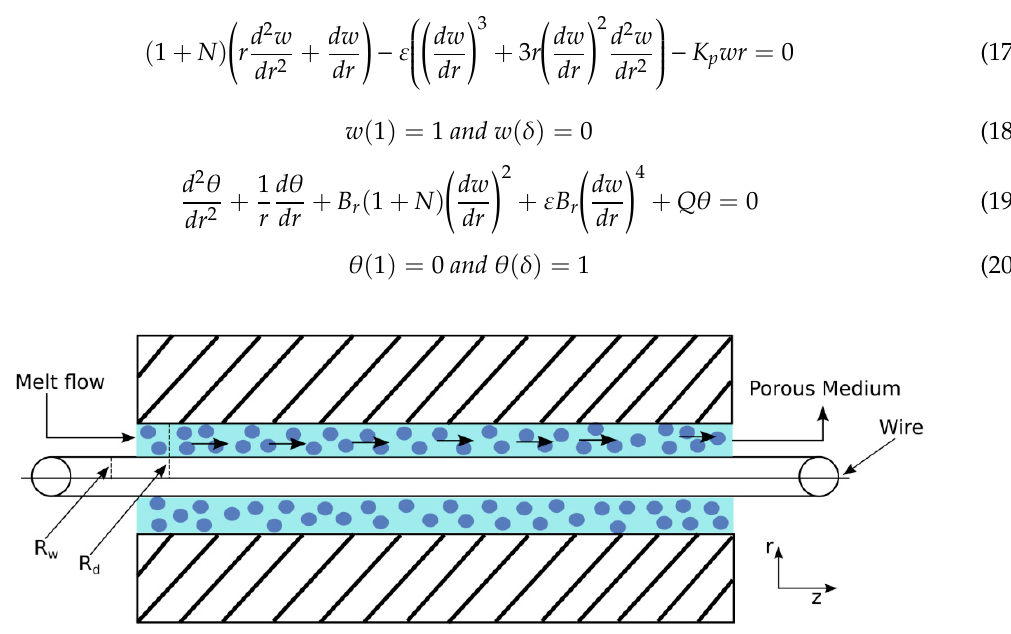
Figure 1. Geometry of the model problem.